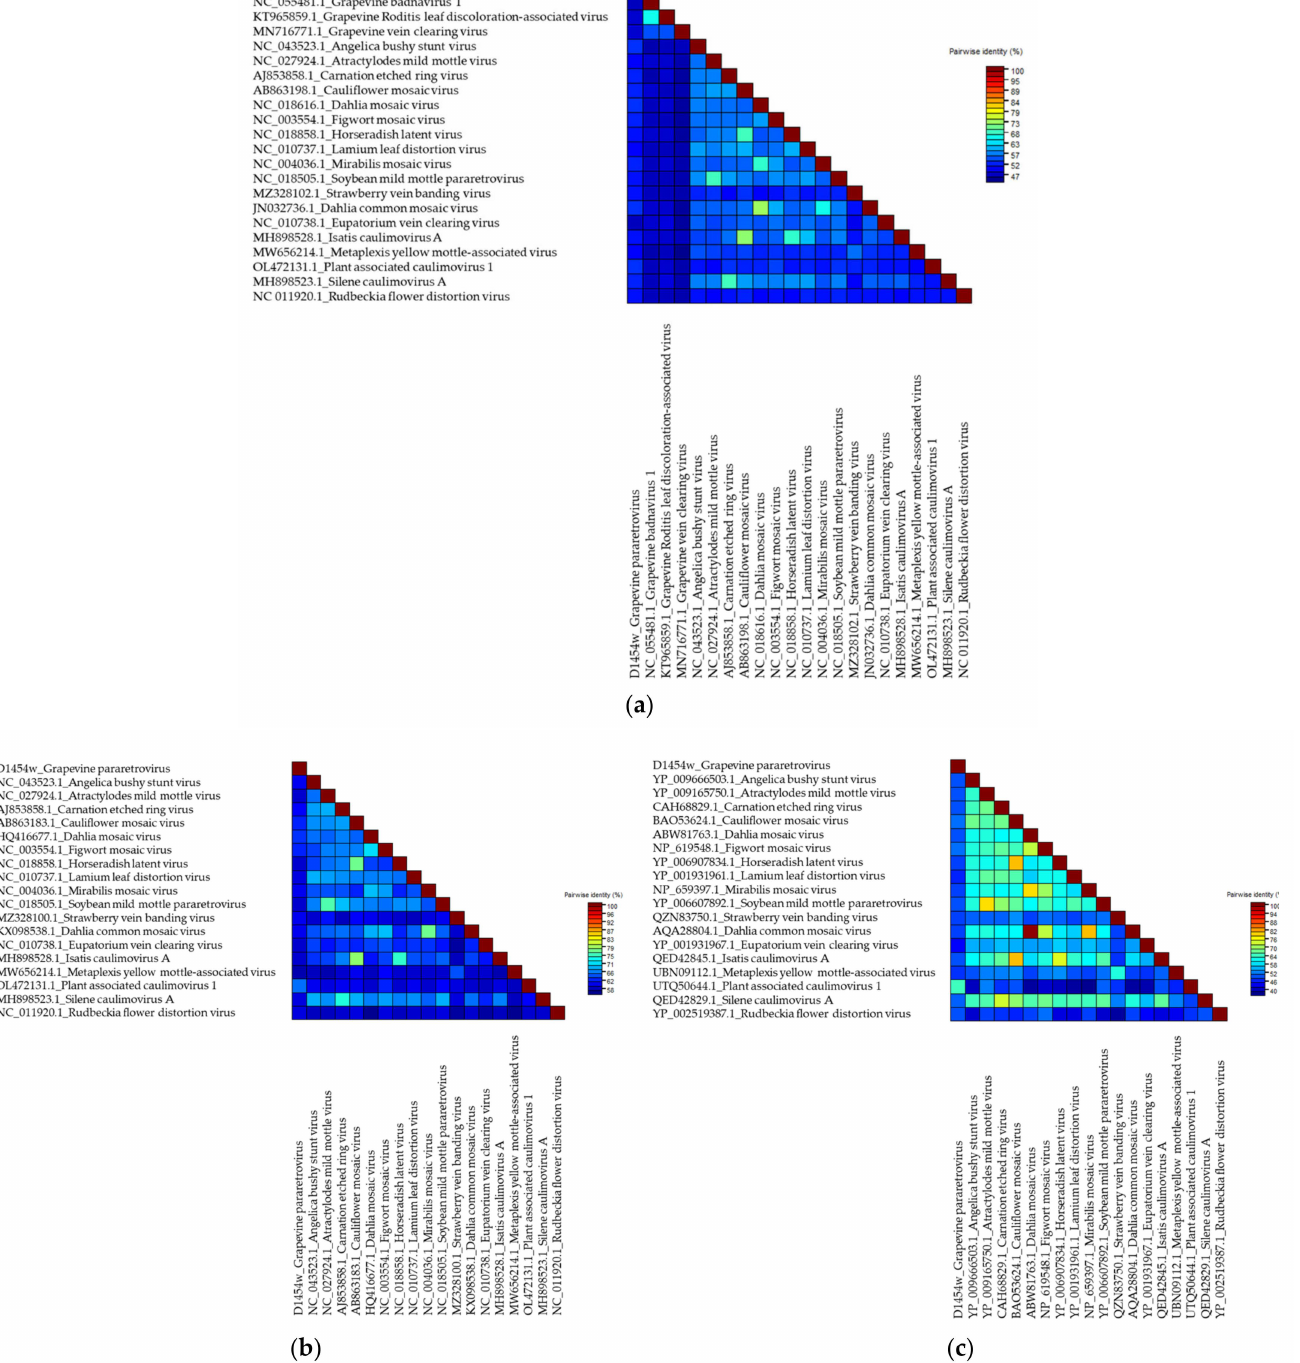
Figure 6. Color-coded pairwise identity matrix including ( a ) complete genomes, ( b ) nucleotide sequences of polymerase region and ( c ) amino acid sequences of polymerase region of grapevine pararetrovirus, representative isolates of the genera Ruflodivirus , Caulimovirus , including unclassified Caulimovirus , and Badnavirus . GenBank accession numbers for each isolate are present by virus isolate names and are also in Supplementary Table